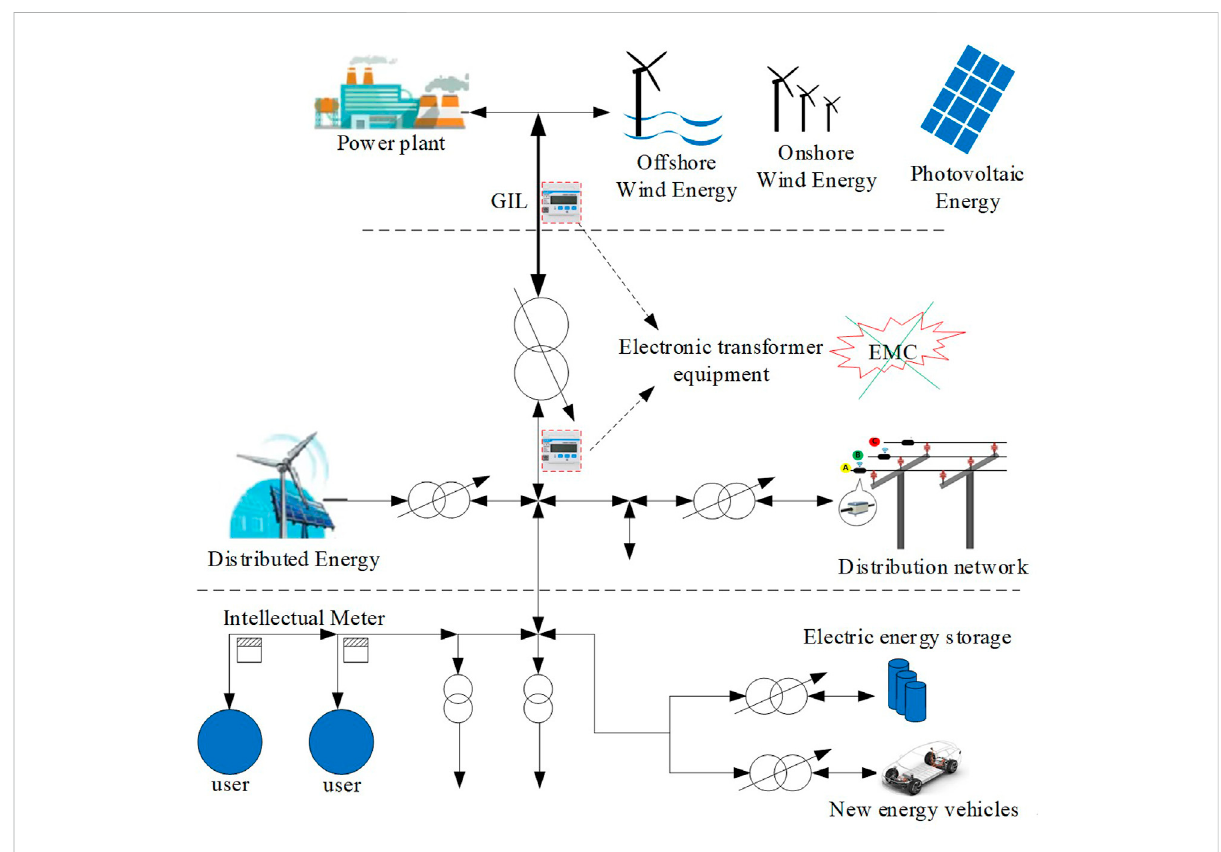
FIGURE 14 New power system structure